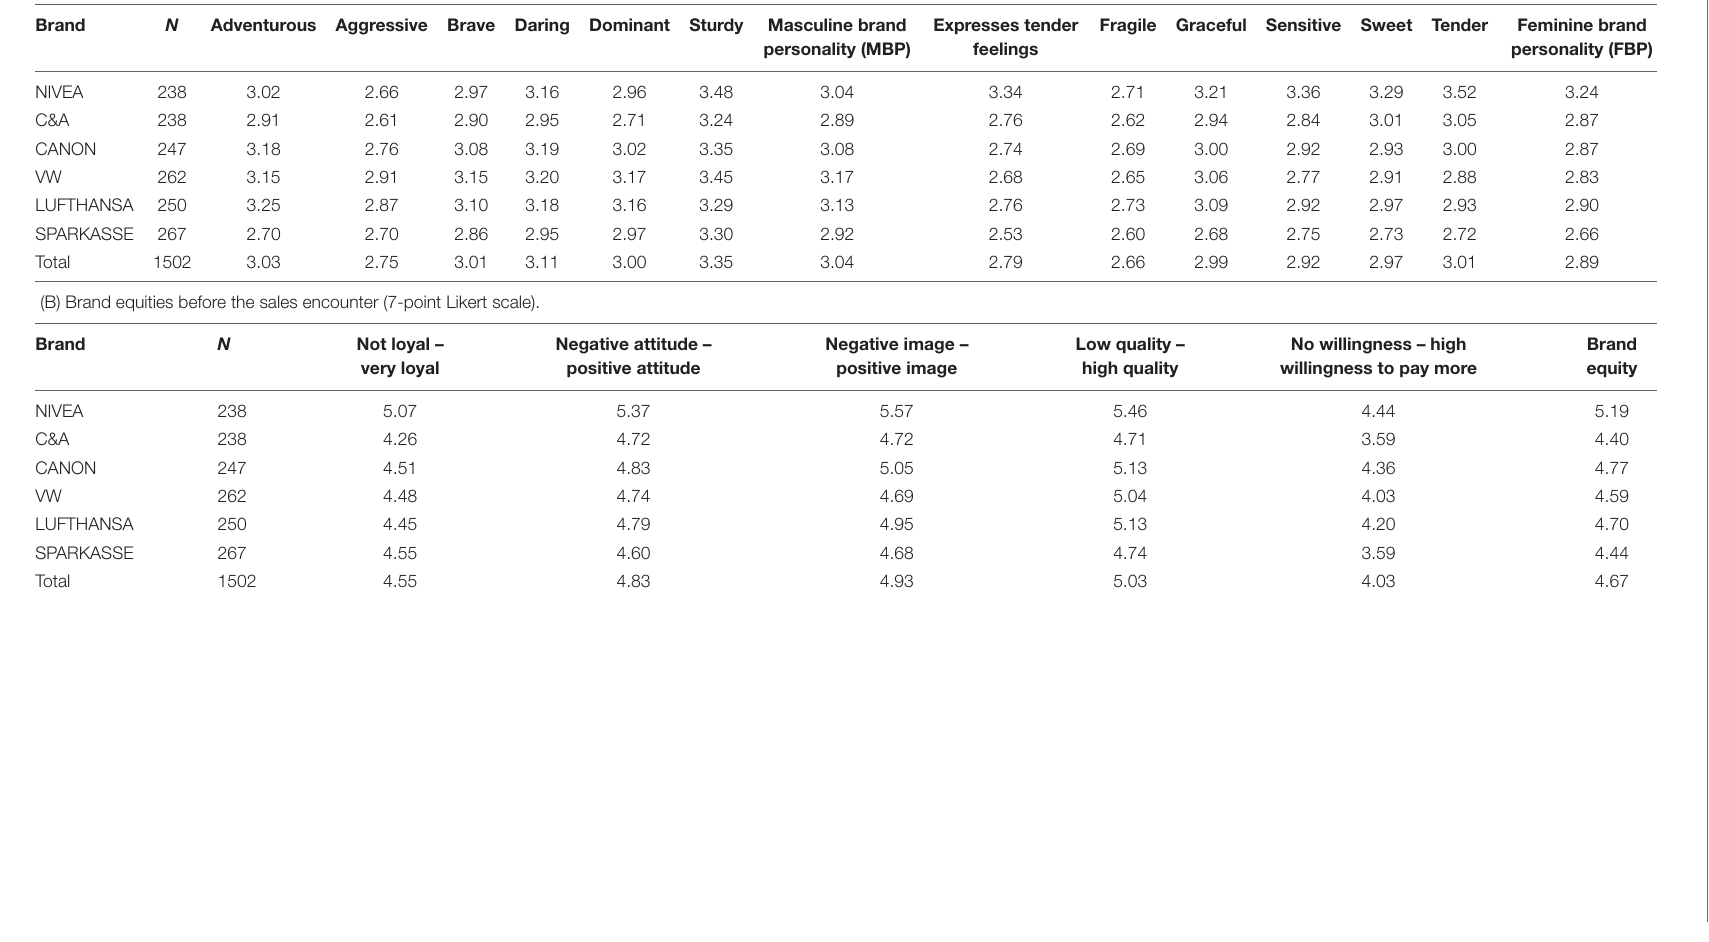
TABLE 1 | (A) Brand personalities before the sales encounter (5-point Likert scale). Brand N Adventurous Aggressive Brave Daring Dominant Sturdy Masculine brand